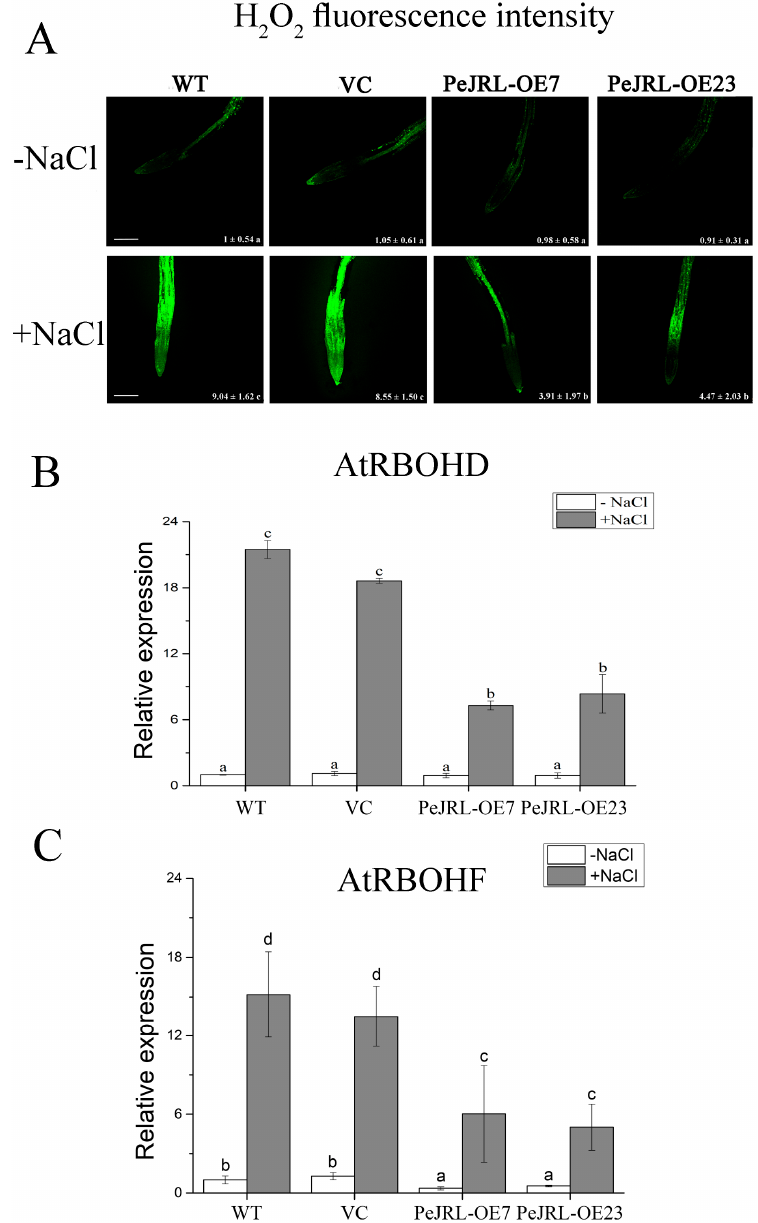
Figure 9. Effect of NaCl on root H 2 O 2 production, AtRBOHD and AtRBOHF expression in wild-type (WT) Arabidopsis, vector control (VC), and PeJRL -transgenic lines (OE7 and OE23). ( A ) H 2 O 2 fluorescence intensity. Seven-day-old seedlings were treated without or with NaCl (125 mM) for 12 h. Roots were then incubated with 2 (cid:48) , 7 (cid:48) -dichlorodihydro-fluorescein diacetate (H 2 DCF-DA, 10 µ M) for 5 min. Green fluorescence within cells was detected at the apical region of roots under a Leica confocal microscope. Representative confocal images of H 2 O 2 production in control ( − NaCl) and salt-stressed roots (+NaCl) are shown. Values ( ± SE) show the mean fluorescence intensity of H 2 DCF-DA. Each value corresponds to the mean of three replicated experiments and values labelled with different letters (a–c) indicate significant differences at p < 0.05. ( B ) AtRBOHD and ( C ) AtRBOHF expression. Five-day-old seedlings were transferred to MS medium containing 0 or 75 mM NaCl for 10 days. AtRBOHD and AtRBOHF transcription were detected with RT-qPCR. The Arabidopsis AtACTIN2 was used as the internal control. Primers designed to target AtRBOHD , AtRBOHF , and AtACTIN2 genes are shown in Supplementary Materials Table S1. Each column corresponds to the mean of seven independent plants, and bars represent the standard error of the mean. Columns labelled with different letters (a–d) denote significant difference at p < 0.05. Scale bar = 250 µ m ( A